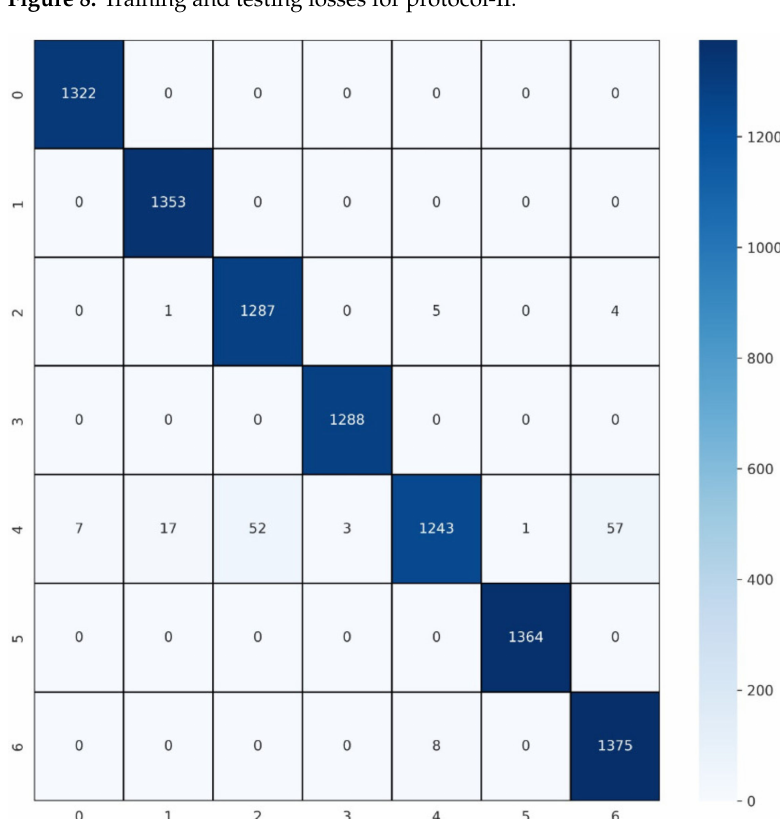
Figure 9. Confusion matrix for